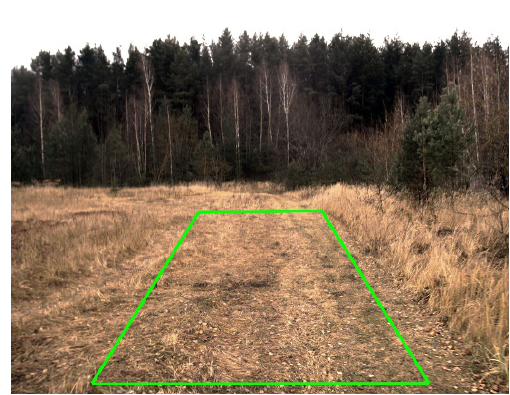
Figure 4 . Area of interest for calculating the optical flow of a monocular block.